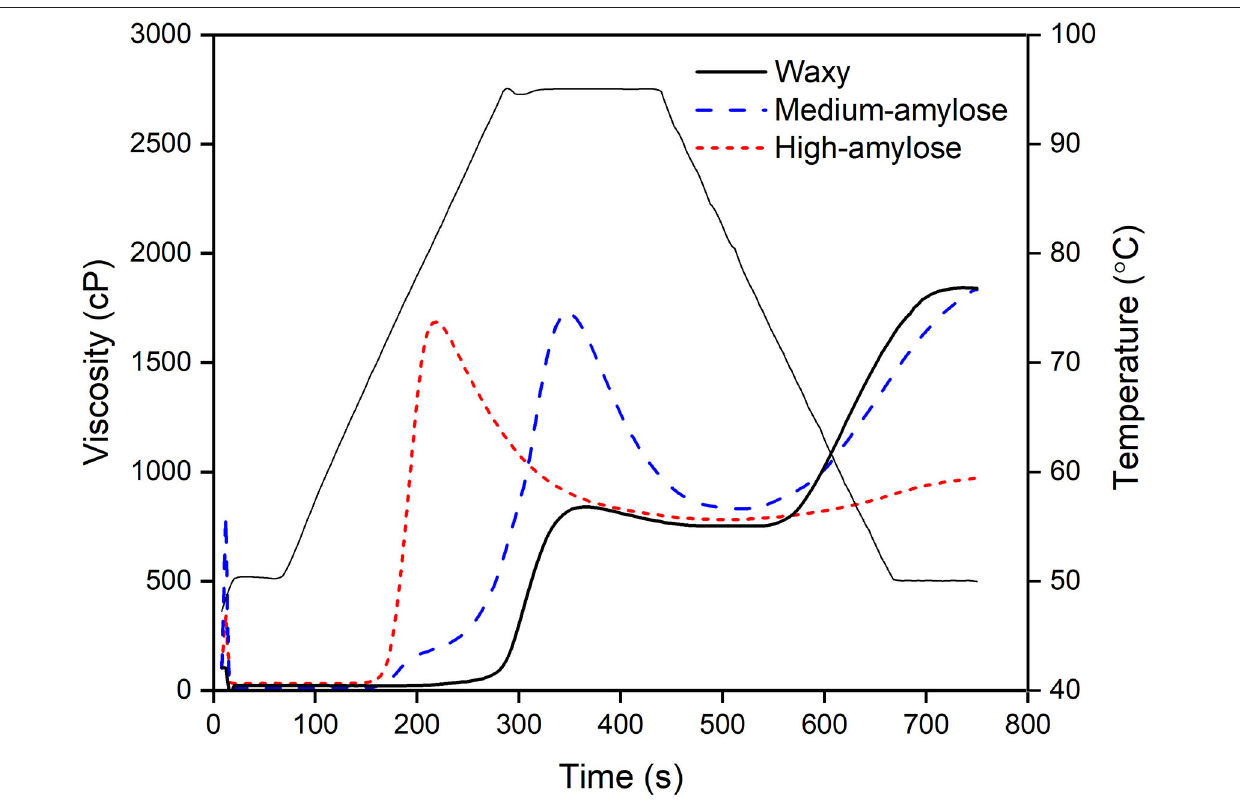
(T 2 ) curves were obtained using the Carr-Purcell-Meiboom-Gill (CPMG) pulse sequence. The measurement parameters were as follows: receiver bandwidth = 200 kHz, repeat sampling wait time = 2,000 ms, analog gain = 15db, digital gain = 3, pre- amplifier gain = 3, number of echoes = 10,000, echo time = 0.1 ms, and scan number =